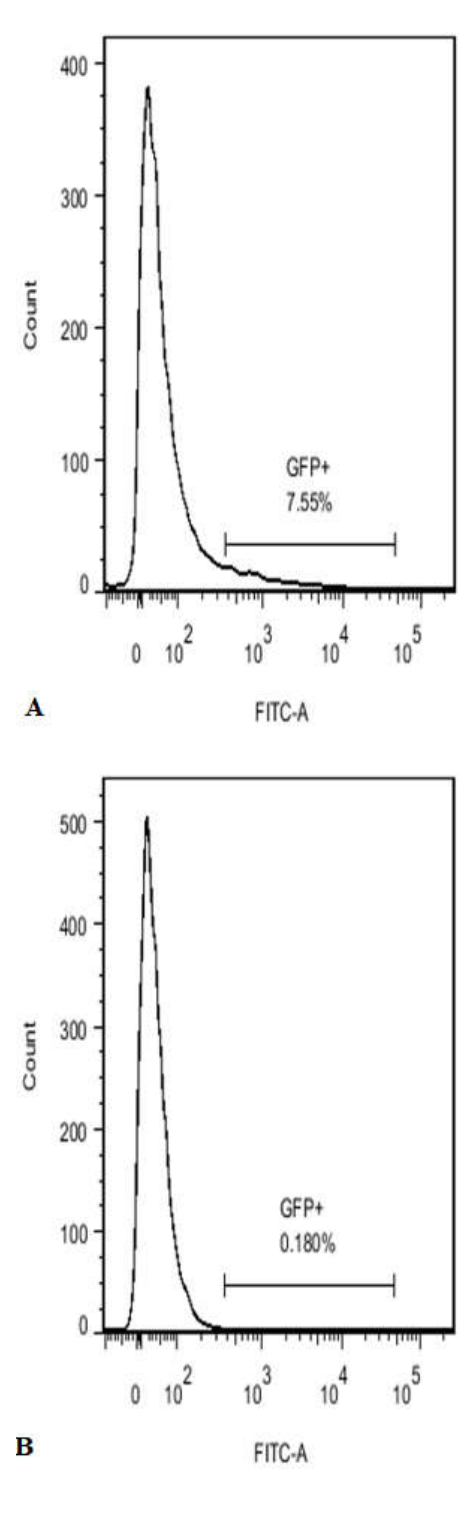
Fig. 5. Isolation of transfected PBMCs by FACS: A) 3-5 days after transfection. It shows that 7.55 % of GFP produced by PBMCs was sorted by machine. B) Negative control, no produced